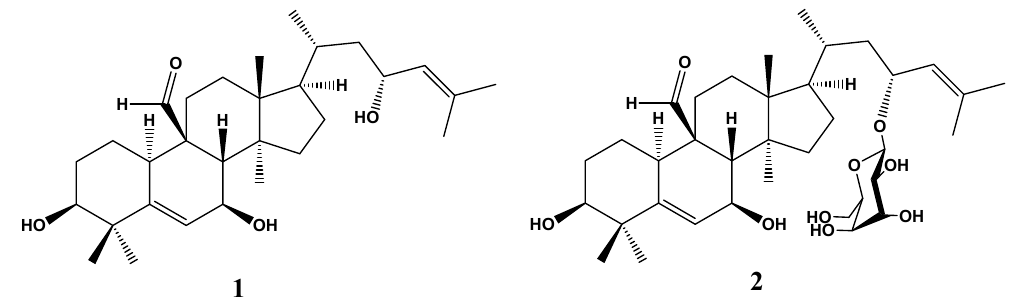
Figure 1. Chemical structure of momordicin I ( 1 ) and momordicin II ( 2 ).